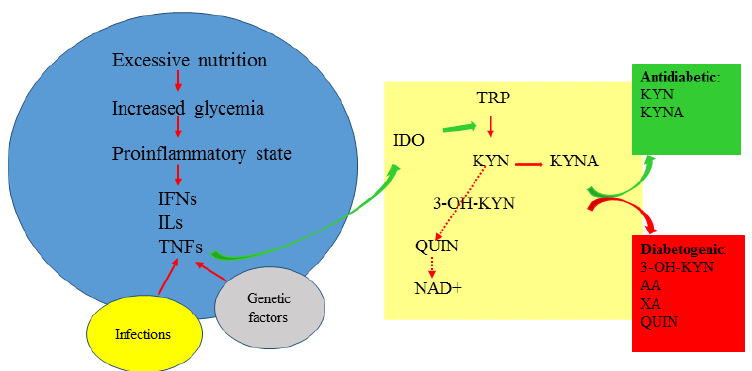
Figure 2. The kynurenine pathway in diabetes. 3-OH-KYN: 3-hydroxykynurenine; AA: anthranilic